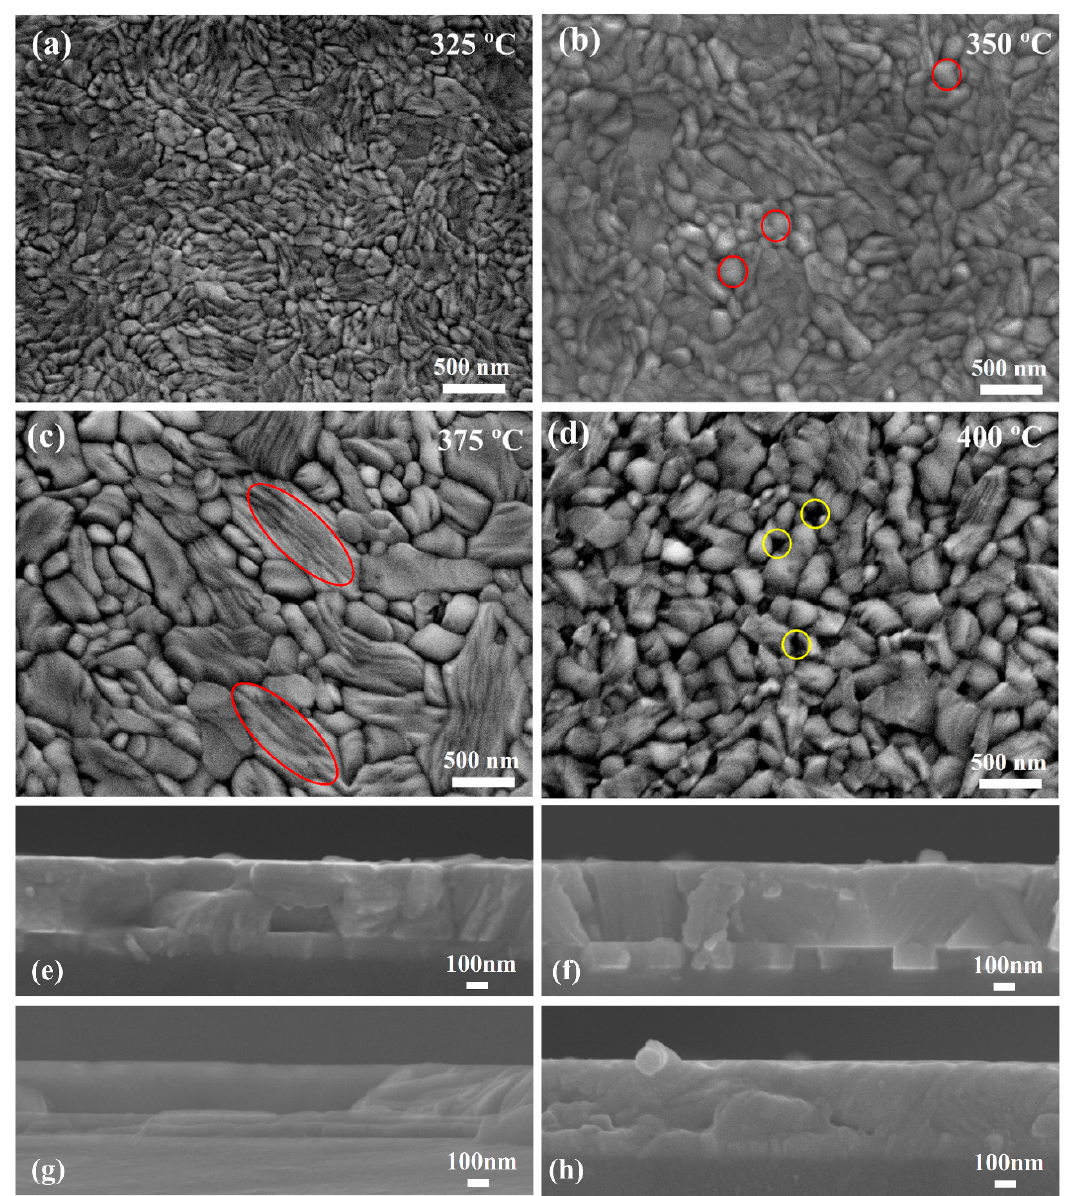
Figure 4. Top-views and cross-section SEM images of the Te-Sb 2 Se 3 thin films annealed at ◦ temperatures of ( a, e ) 325, ( b, f ) 350, ( c, g ) 375, and ( d, h ) 400 °C. of ( a , e ) 325, ( b , f ) 350, ( c , g ) 375, and ( d , h ) 400